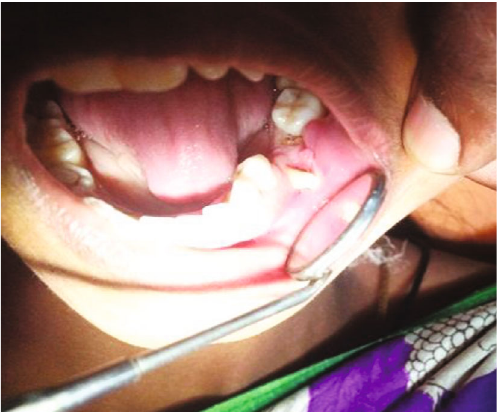
Figure 1: Clinical photograph showing a solitary, fi rm, ulcerative tissue measuring 2 × 2 centimetres on the alveolar mucosa near the premolar region.